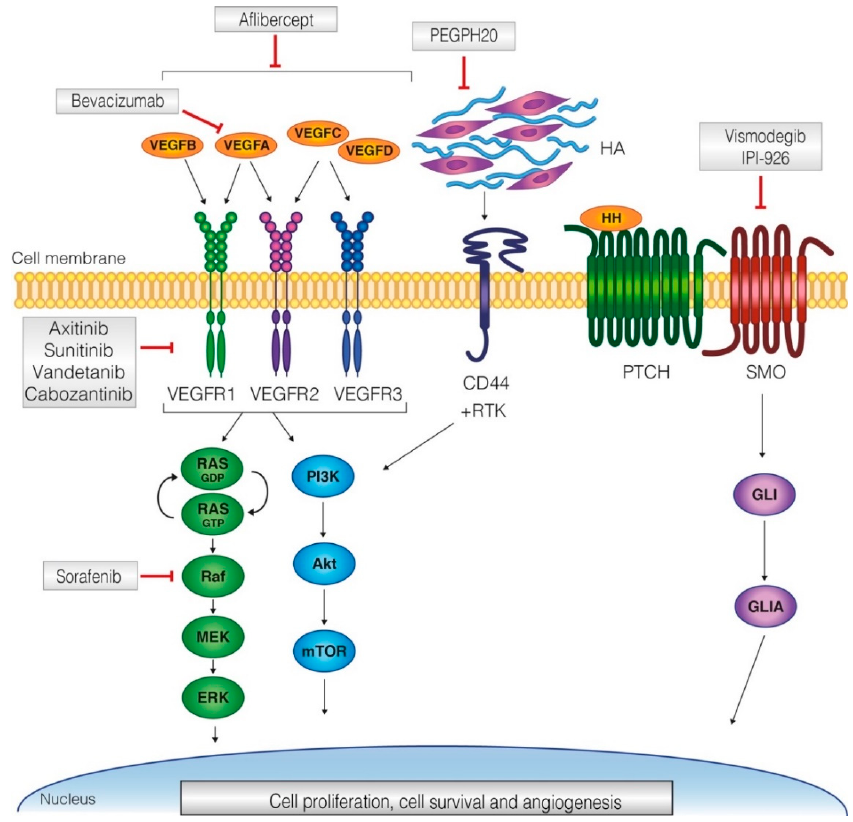
Figure 1. Schematic overview of pathways that are involved in desmoplasia in pancreatic cancer, including drugs and their targets. The vascular endothelial growth factor (VEGF) pathway is activated through ligand binding to any of the three